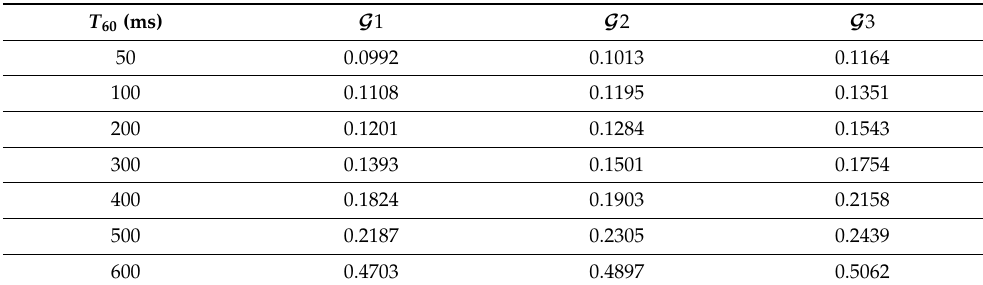
Table 2. RMSE versus T 60 under different graphs with SNR = 20 dB.